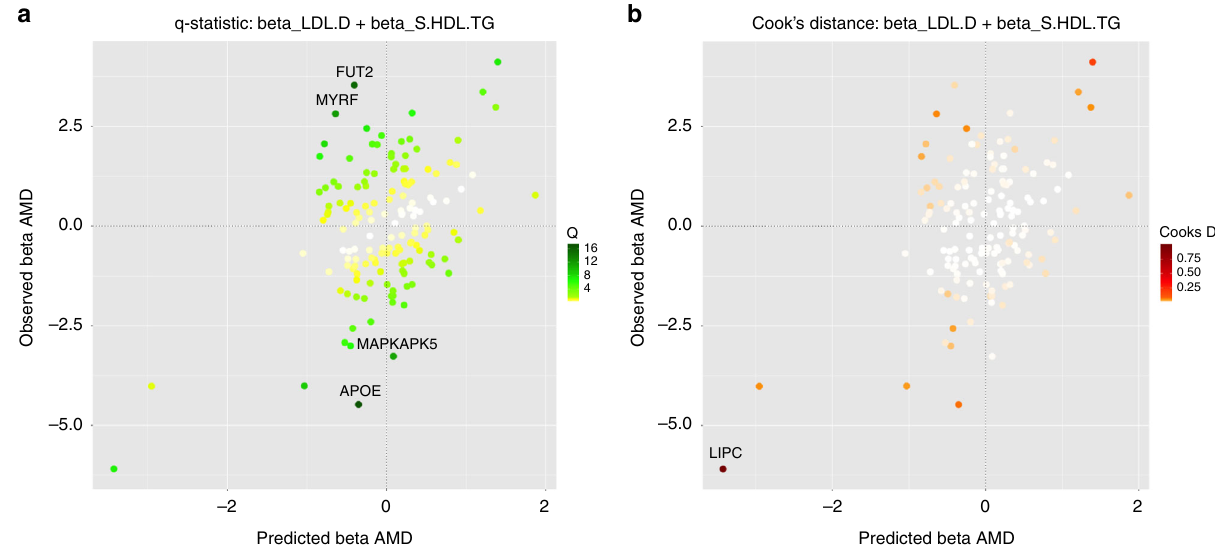
Fig. 4 Diagnostic plots for outliers and in fl uential genetic variants. Plotting the predicted associations with AMD based on the model including LDL.D, and S.HDL.TG ( x -axis) against the observed associations with AMD ( y -axis) showing all n ¼ 148 genetic variants. This is the highest-ranking model when keeping outlying and in fl uential genetic variants in the analysis. The colour code shows: a the q -statistic for outliers and b Cook's distance for the in fl uential points. Any genetic variant with q -value larger than 10 or Cook's distance larger than the median of the relevant F -distribution is marked by a label indicating the gene region. Table 2 Ranking of risk factors for age-related macular degeneration (AMD) according to their marginal inclusion probability (MIP) after exclusion of outlying and in fl uential variants ( n ¼ 145).